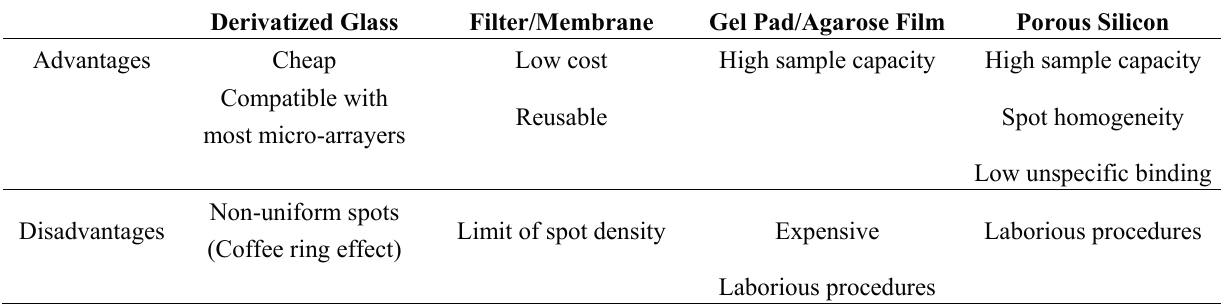
Table 1. Solid microarray